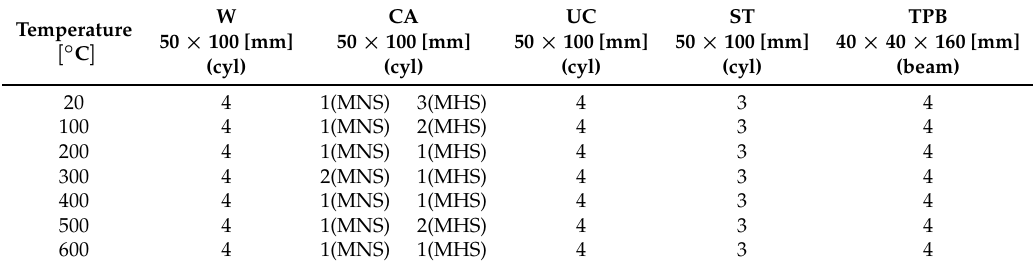
Table 4. Overview of the experimental program. The number in the table indicates the number of repetitions per test-type (for either MNS or MHS, except in the case of